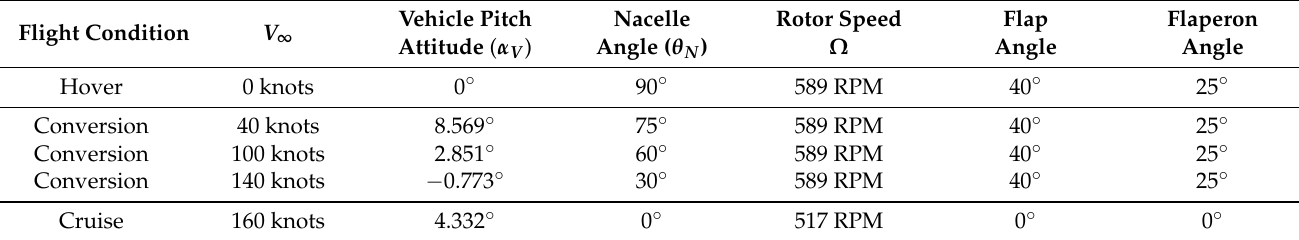
Table 4. Parameters of the full XV-15 vehicle configurations considered for the numerical